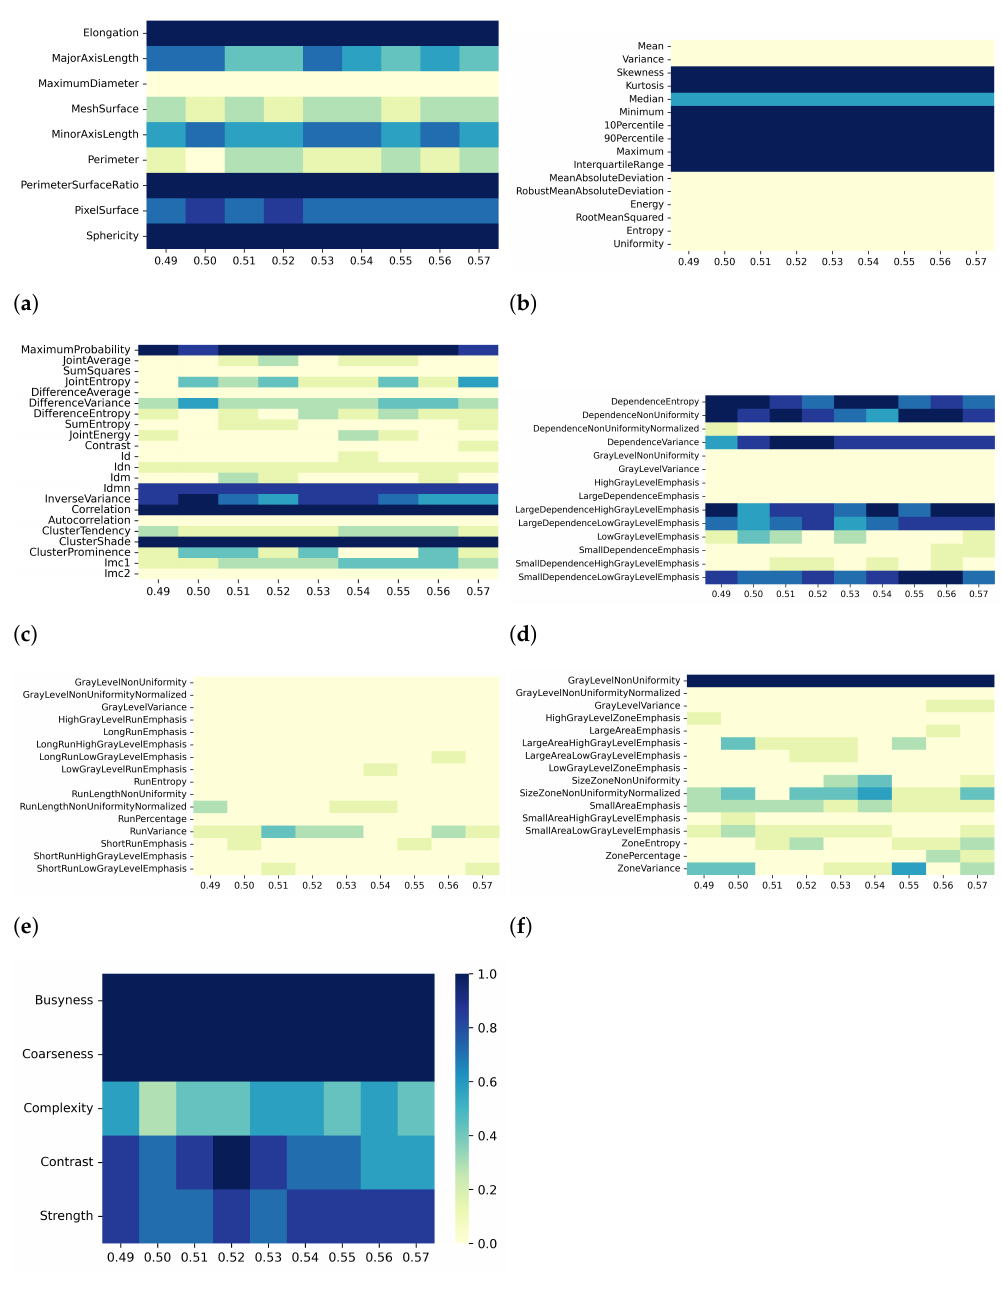
Figure 7. Heatmaps of remaining features from T2 maps after SCC-based dimensionality reduction for effect A (varying resampling voxel size, with fixed discretization bin width (ms)). The radiomic features are separated in classes: ( a ) 2D shape, ( b ) first order, ( c ) GLCM, ( d ) GLDM, ( e ) GLRLM, ( f ) GLSZM, ( g )